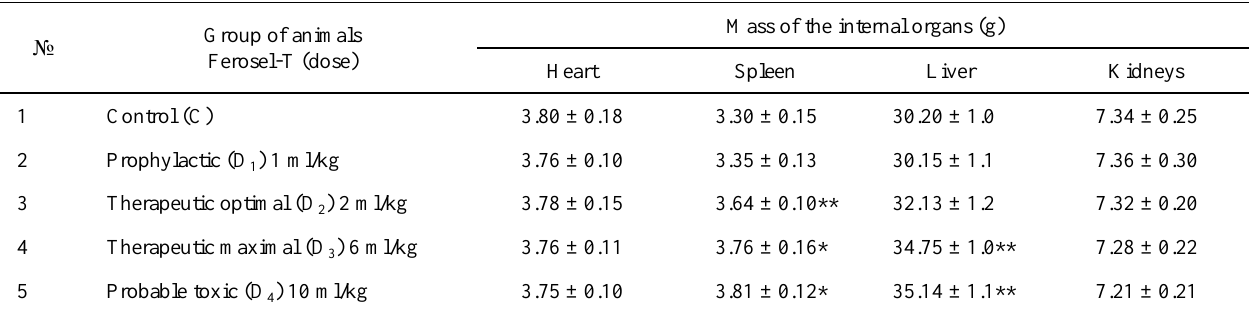
The coefficients of the mass of the internal organs of the laboratory rats after the introduction of the ferrocellus T (M ± m; n =